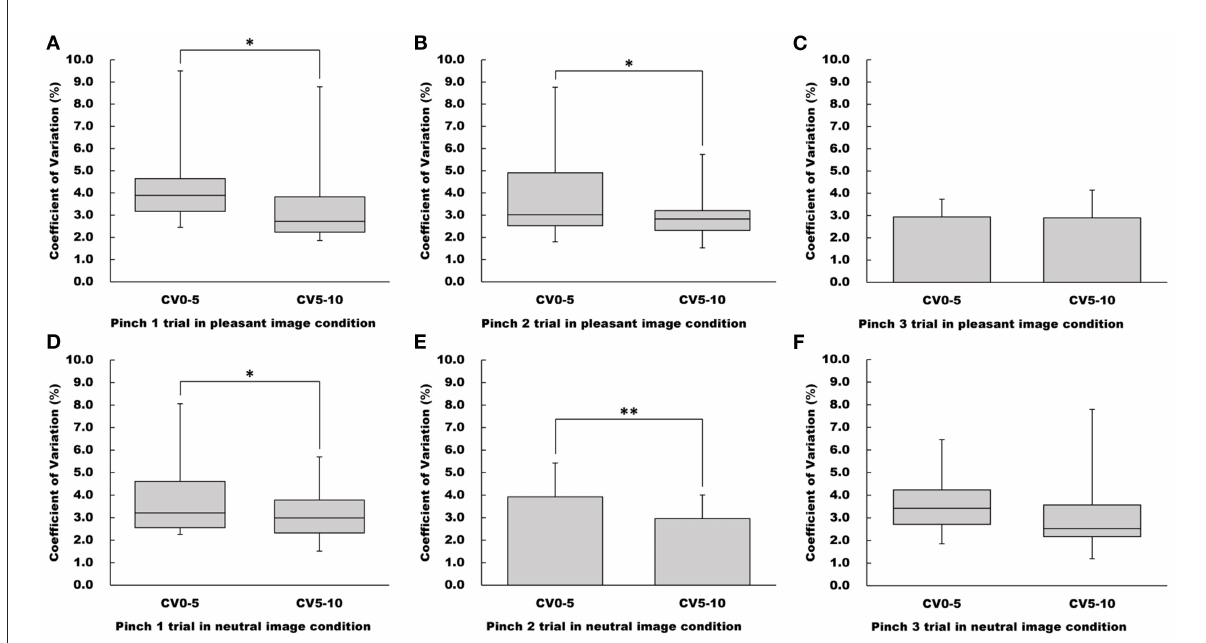
FIGURE4 Influence of duration on CV values in the pleasant and neutral image conditions. (A–C) Show CV value in the pleasant image condition, respectfully. (D–F) Show CV value in the neutral image condition, respectfully. For parametric data, CV values are represented as mean and standard deviation. For non-parametric data, CV values are represented using the box and whisker plot, with the median shown as the middle horizontal line, the upper and lower quartiles indicated as boxes, and the maximum and minimum indicated as whiskers. The vertical axis shows CV value (%), and horizontal axis shows the specific duration (CV 0 − 5 and CV 5 − 10 ). * p < 0.05, ** p < 0.01.